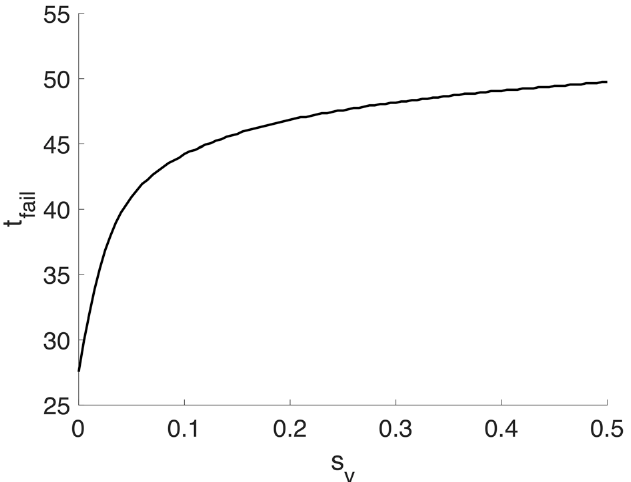
Figure 5. Predicted time to treatment failure ( t fail ) as a function of Provenge dose strength ( s V ) when administered concurrently with